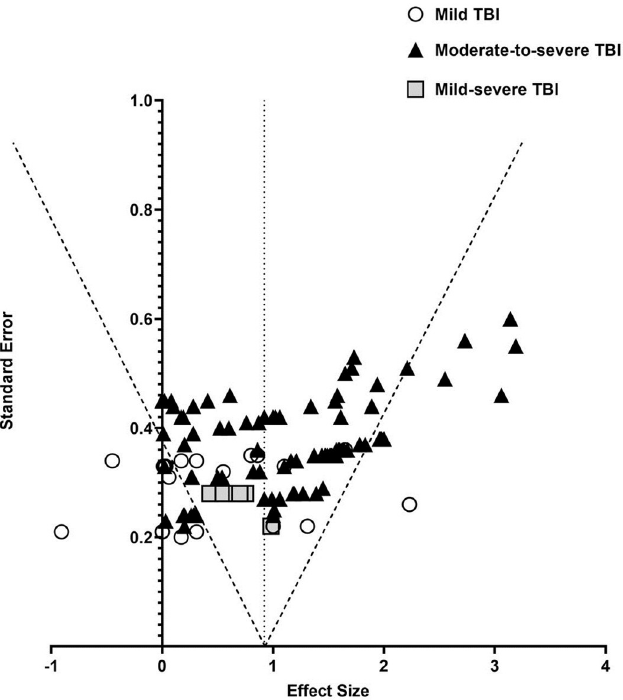
Fig 2. Funnel plot for publication bias. Funnel plot analysis, indicating potential publication bias. The different symbols represent the severity subgroups which may account for this bias.